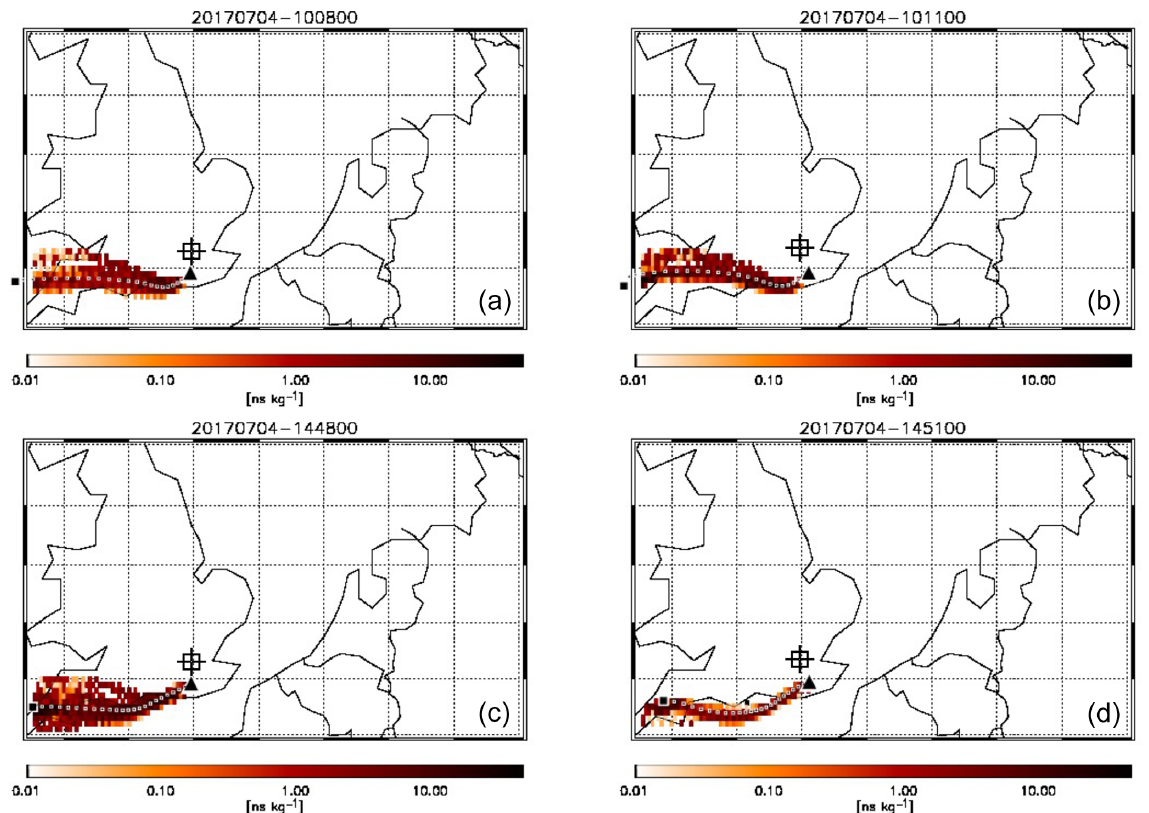
Figure 7. FLEXPART modelled footprint of air mass arriving at the location of FAAM BAe-146 (black triangles) at 10:08 and 10:11 during flight C017 (a, b) and at 14:48 and 14:51 during flight C018. Each coloured pixel indicates the relative contribution of an inert tracer in that air to the total concentration of that tracer sampled on board. The large black square shows the point of release of the air 24h prior to being intercepted by the aircraft. The dotted line of black and white squares shows the hourly weighted average trajectory of the air mass based on the relative contributions shown. The square target indicates the approximate position of central London.